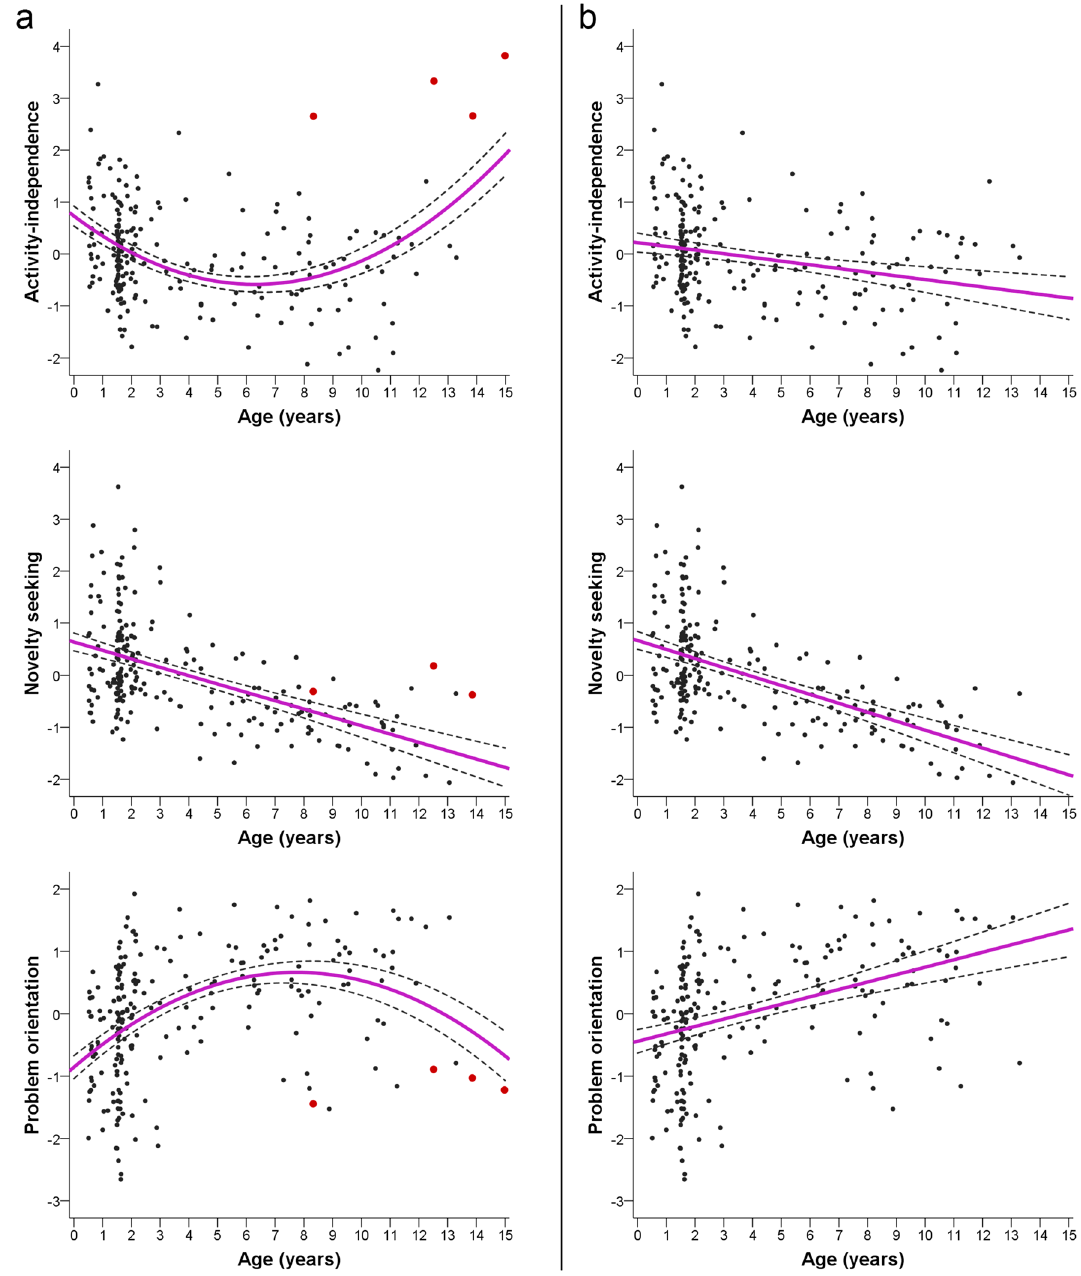
Figure 1. Relationships between age and three personality trait scores of the dogs. ( a ) Relationship on the full sample, the four outlier aged dogs are marked with red dots. ( b ) Relationship after excluding the four outlier aged dogs. Dashed lines represent the 95% confidence intervals of the